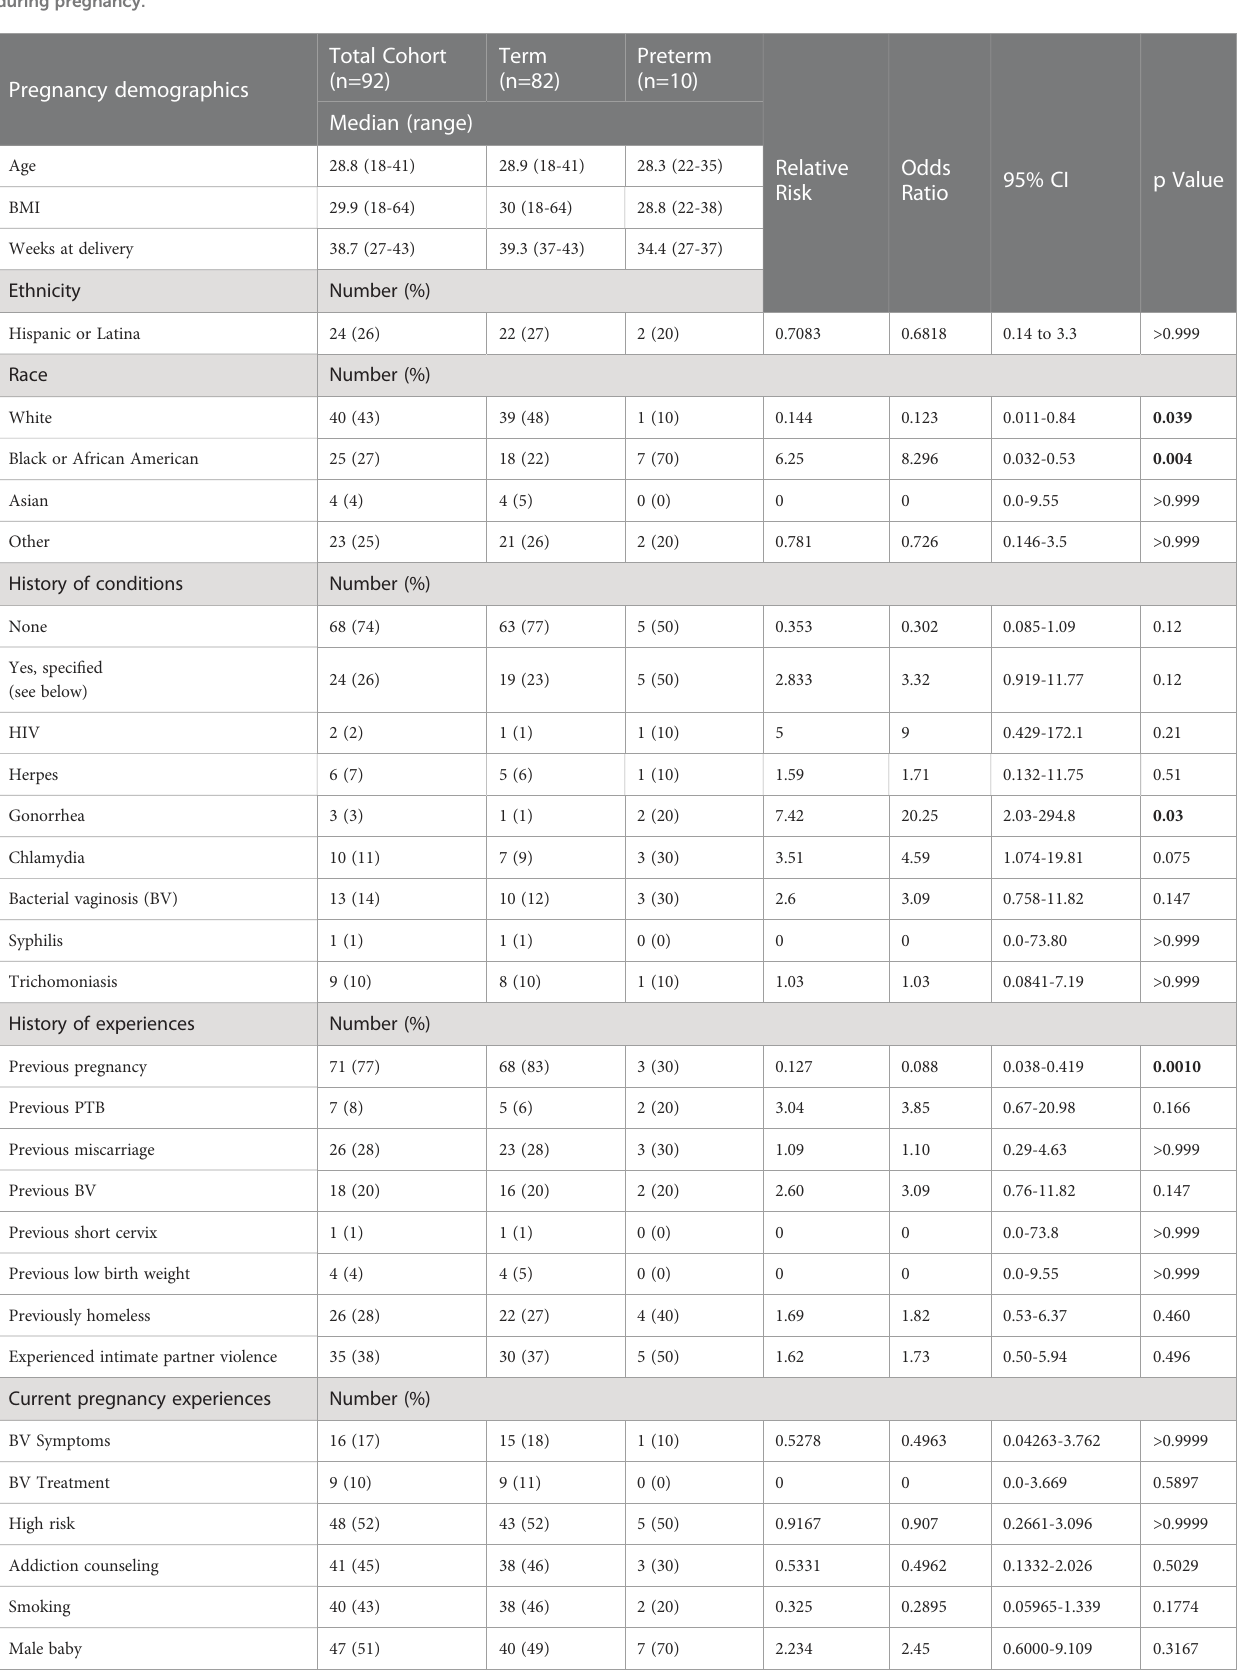
TABLE 1 Demographics and characteristics for participants enrolled in the longitudinal analysis of mucosal barrier properties and vaginal microbiome during